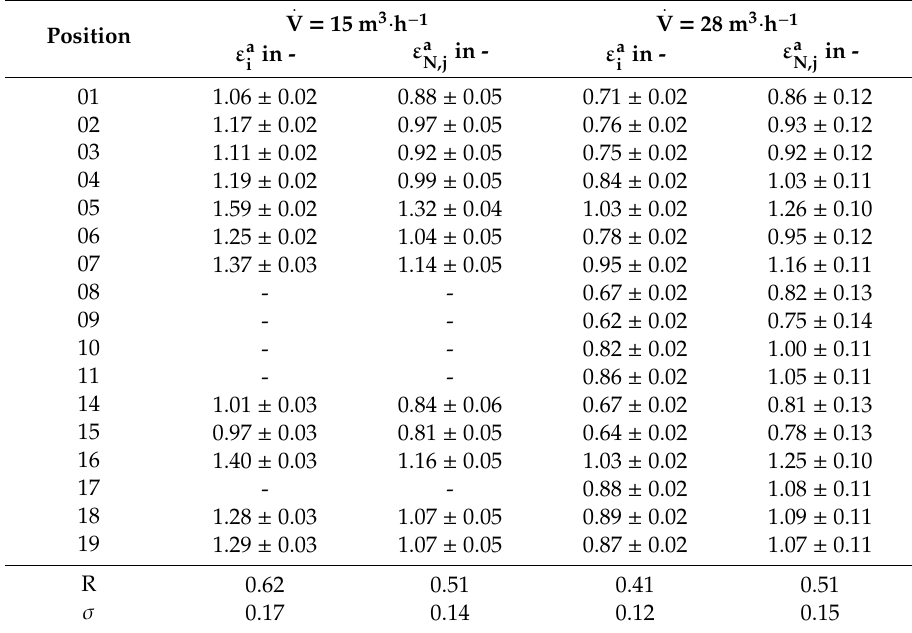
Table A4. Local air exchange at una ff ected supply air conditions + internal heat source of 300 W.